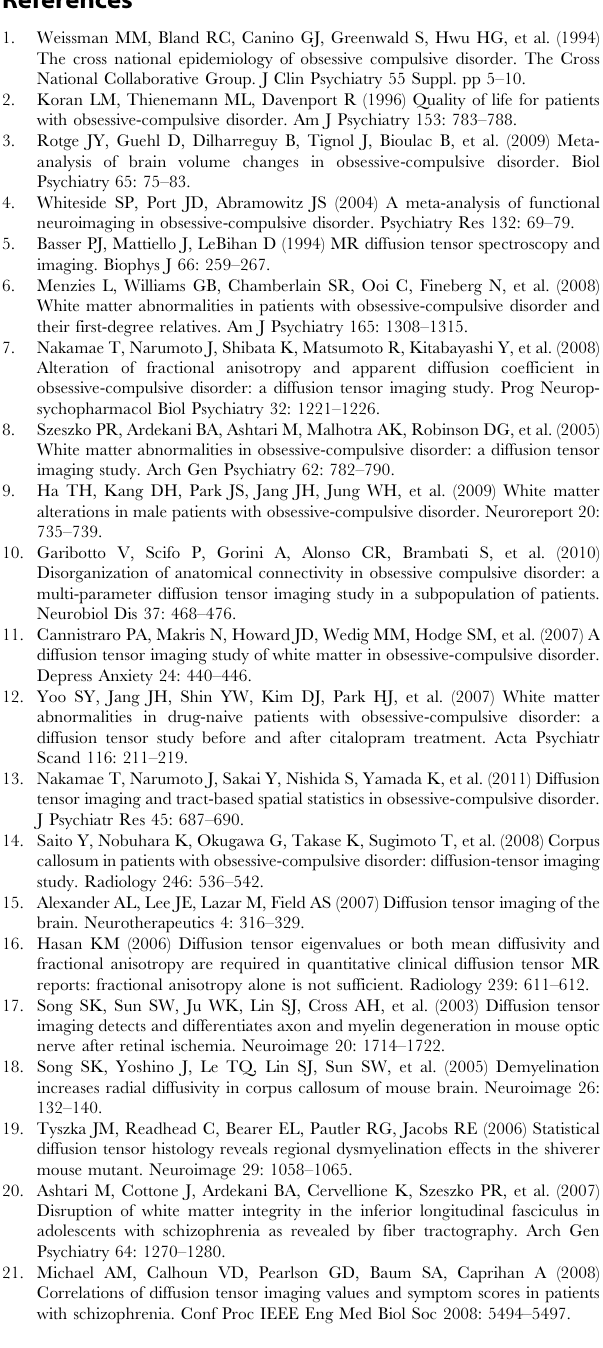
Table S1 Regional differences in FA, RD, AD and MD before and after treatment in OCD